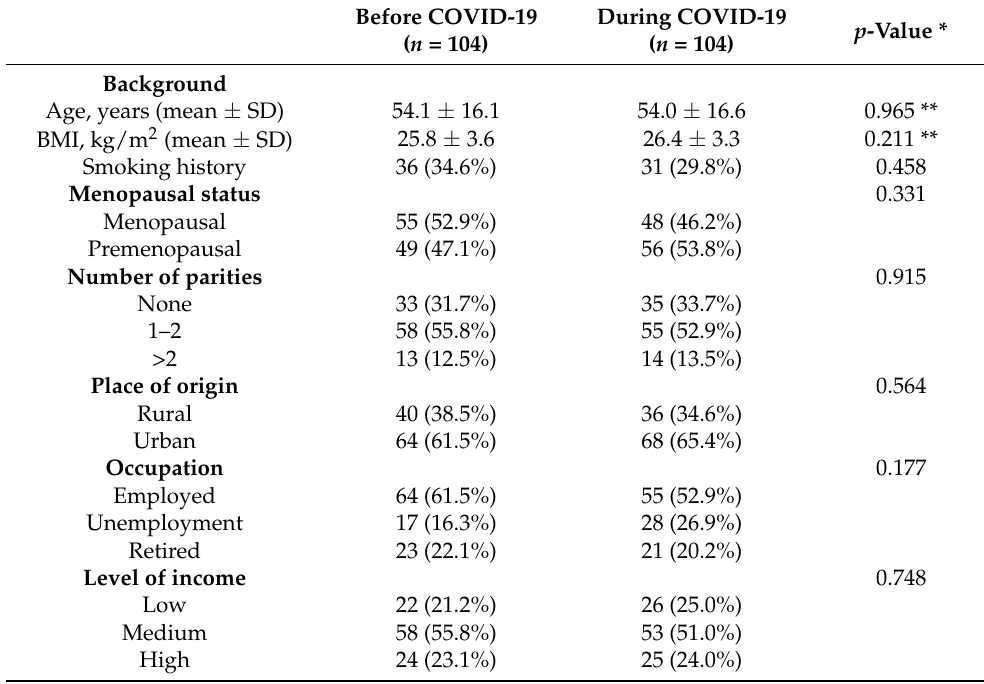
Table 1. Comparison of baseline characteristics of women with cervical cancer undergoing radiation therapy before and during the COVID-19